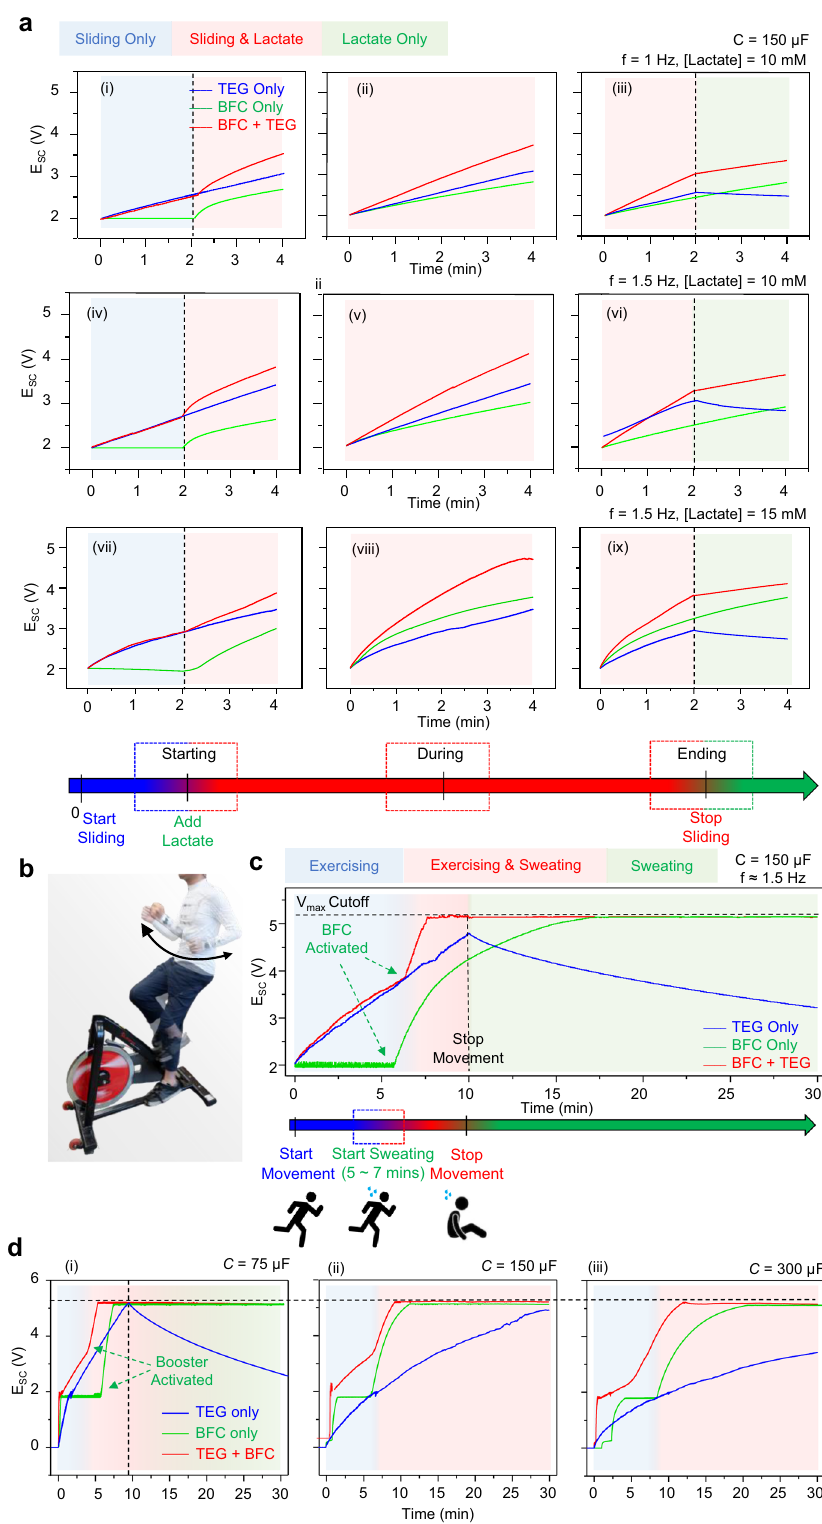
Fig. 5 In-vitro and on-body charging performance of the wearable bioenergy microgrid system. a In-vitro charging curves of the individual and integrated harvester with (i)-(iii) 1 Hz frequency and 10 mM lactate; (iv)-(vi) 1.5 Hz frequency and 10 mM lactate; and (vii)-(ix) 1.5 Hz and 15 mM lactate for the TEG modules and the BFC modules, which simulate three representative phases: starting ((i), (iv), and (vii)), exercising((ii), (v), and (viii)) and ending((iii), (vi), and (ix)) of an activity session. b Photo illustration of the on-body testing arrangement. c On-body charging of a 150 μ F SC using the individual BFC or TEG module alone, and with both modules combined, in a 10-min exercise session followed by a 20-min resting. d On-body charging of capacitors from SCs with (i) 75 μ F, (ii) 150 μ F, and (iii) 300 μ F from 0 V in a 30-min exercise session to represent the charging of the system including the cold-starting phase of the voltage-booster. During the 30-min period, movement stops once the SC if fully charged to 5.1 V. NATURE COMMUNICATIONS| (2021) 12:1542